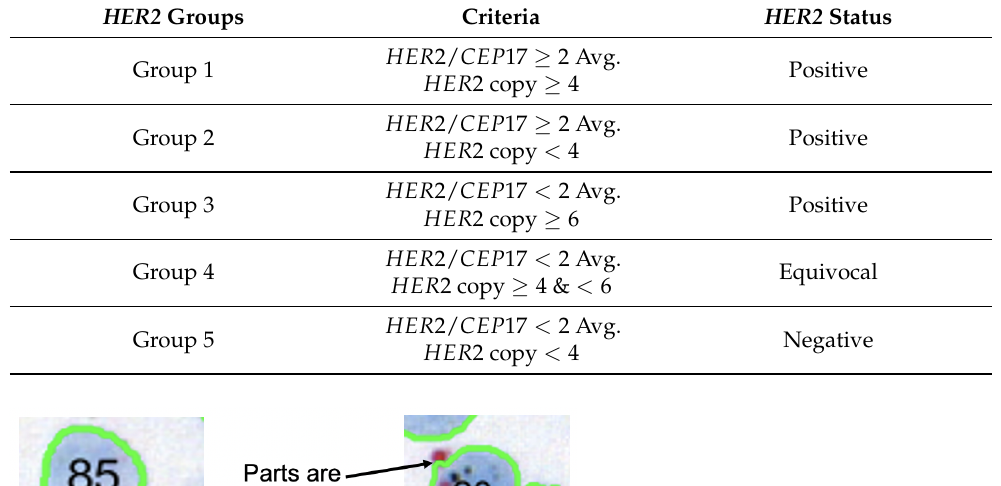
Table 1. HER2 grading based on HER2 and CEP17 counts.